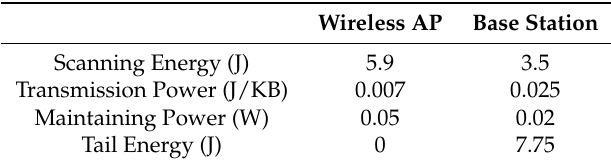
Table 1. Energy consumption parameters